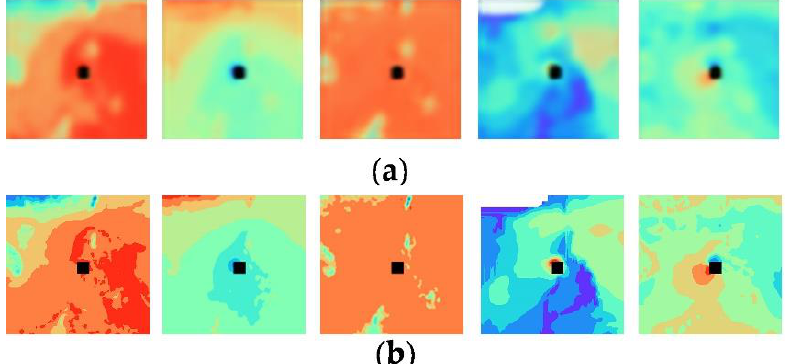
Figure 6. Diagrams showing a comparison between the predicted images of Typhoon PHANFONE (201929) at 0 o ’ clock on 26 December 2019 and the original images. ( a ) Predicted images. ( b ) Original images.